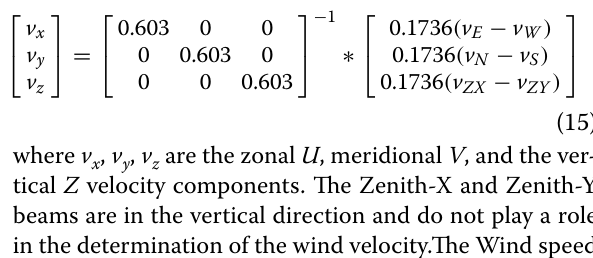
Fig. 3 a RMSE of normalized frequency versus SNR. b Amplitude RMSE versus SNR